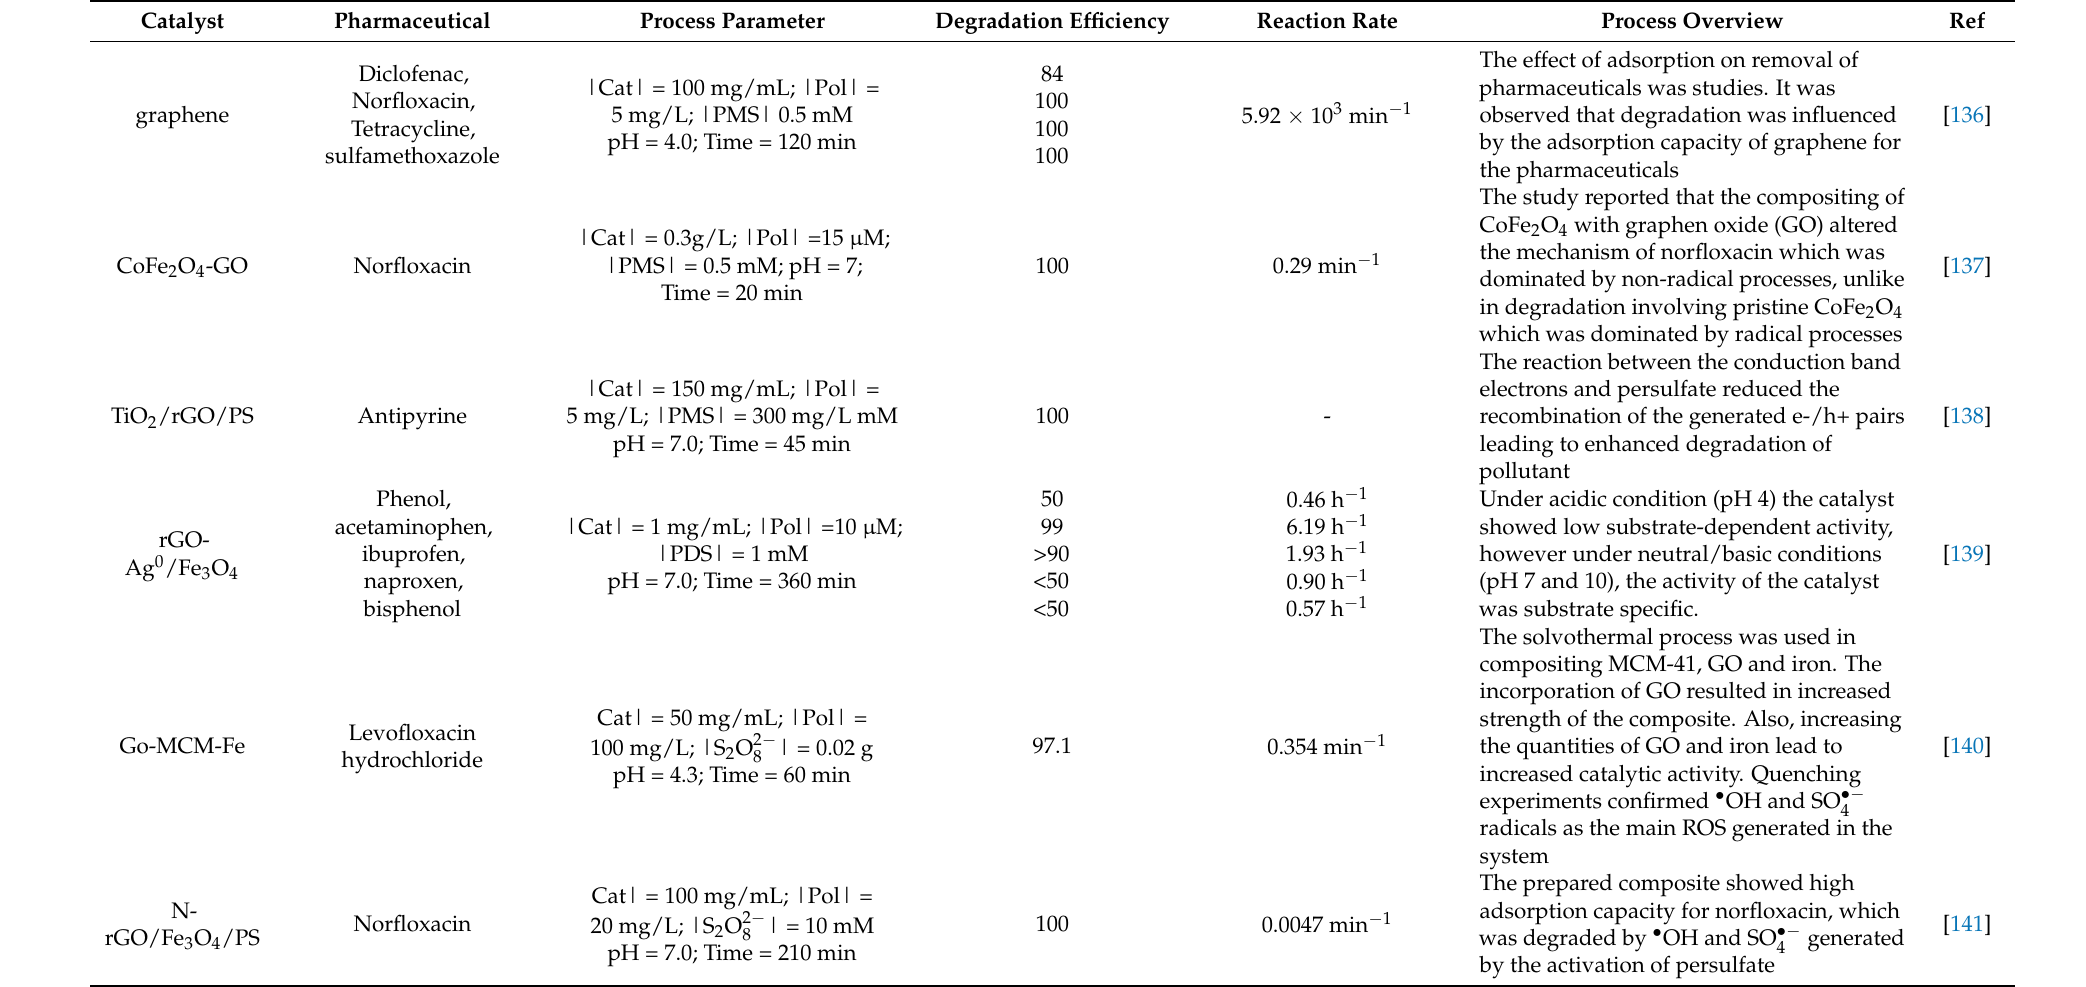
Table 2. Chemical oxidation processes based on graphene-based composites for degradation of